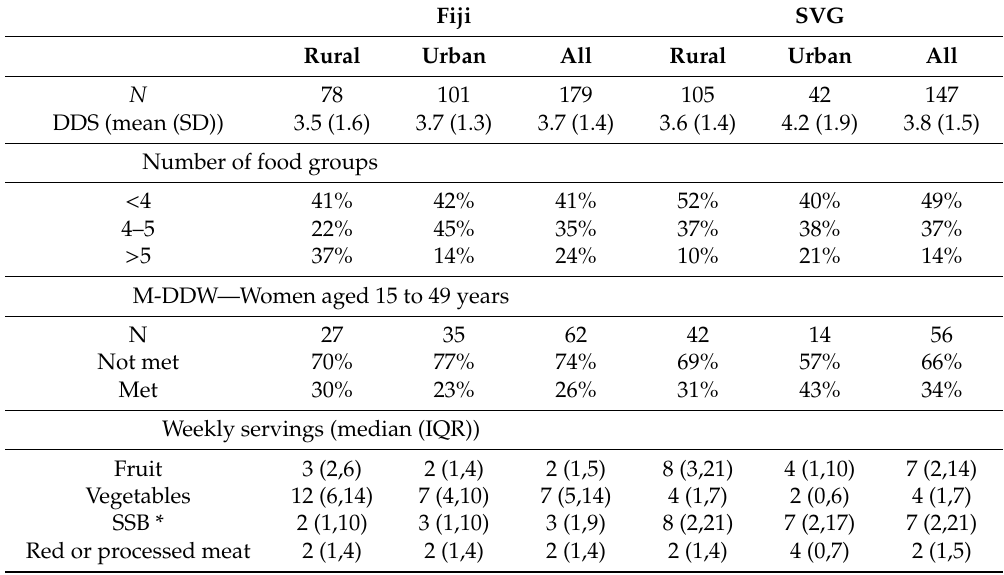
Figure 2. Proportion of respondents (%) in the CFaH project reporting consumption of specific food groups in one 24 h period. Table 3. Aspects of diet in the CFaH project study populations, including the dietary diversity score (DDS), minimum dietary diversity in women of reproductive age (M-DDW), and median weekly servings of selected items.